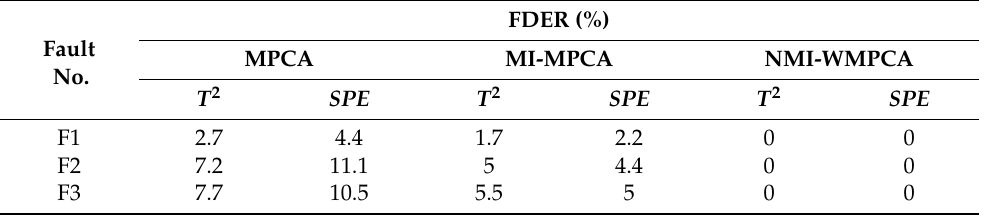
Table 5. Fault detection time (FDT) based on different methods for all of the fault batches.